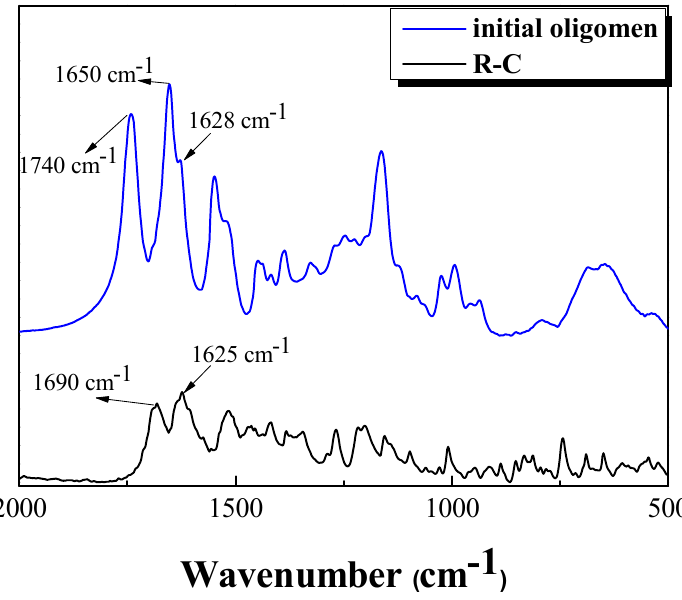
Figure 2. Solid FTIR spectra of pure R-C and the quenched oligomer from the R-C/PLG–NCA mixtures.